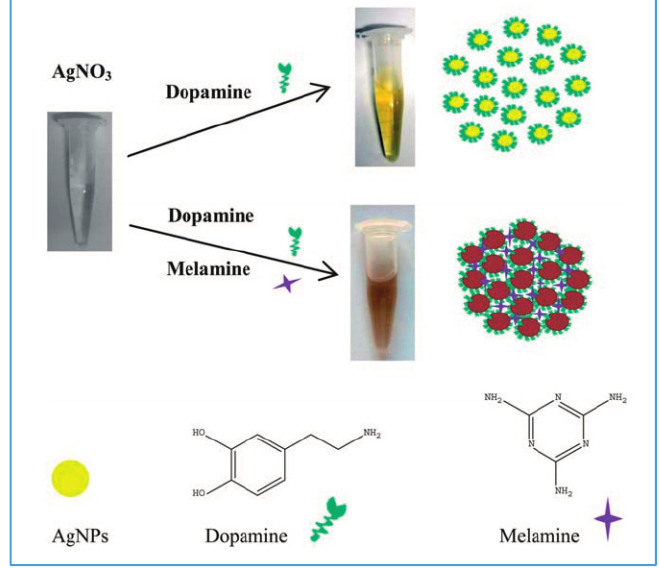
Figure 2. Schematic illustration of colorimetric method with AgNPs/dopamine system for the detection of melamine (reproduced from [48] with permission of The Royal Society of